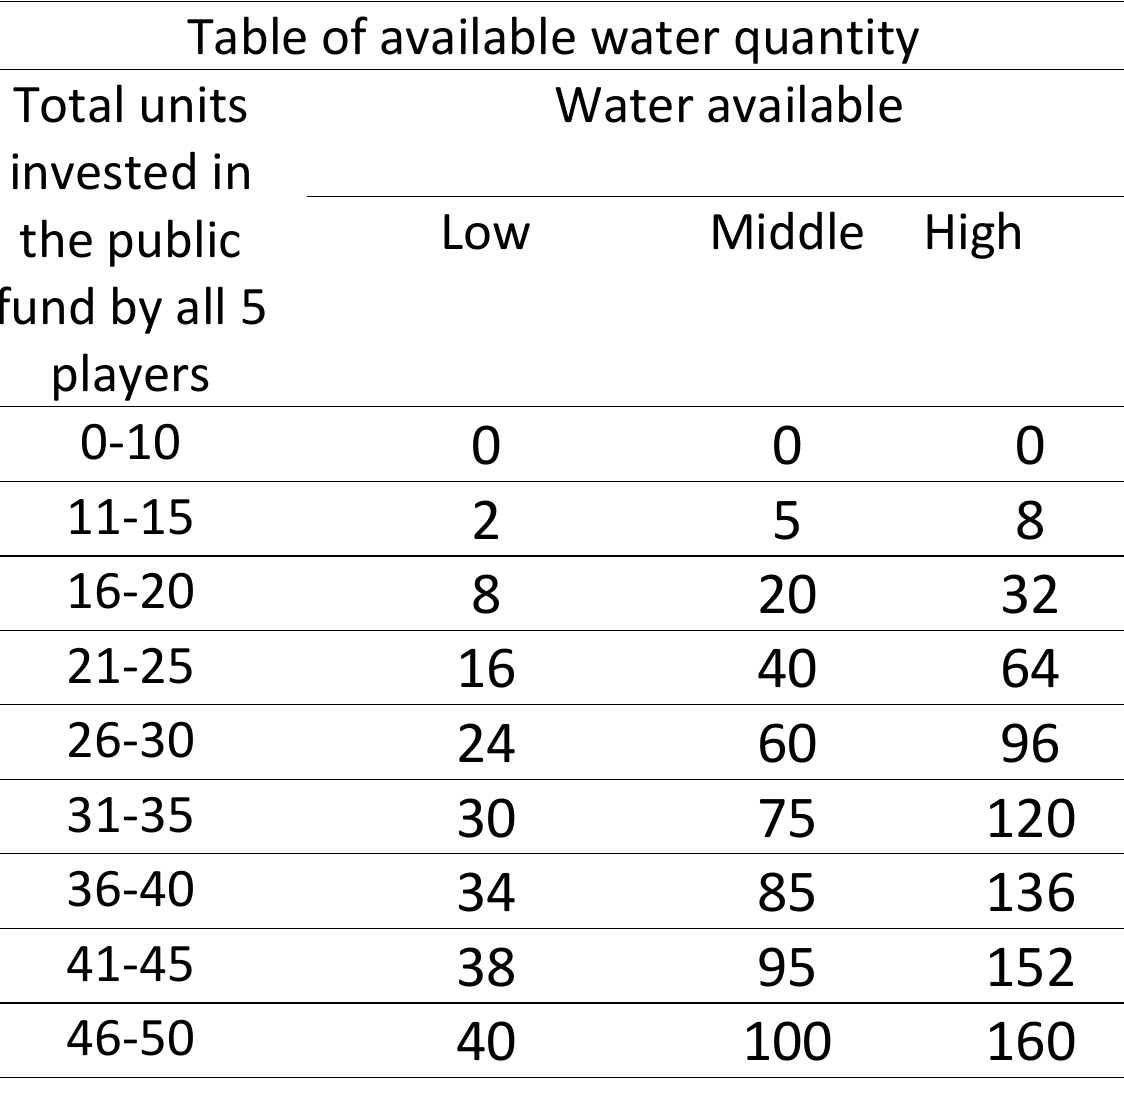
Table of available water